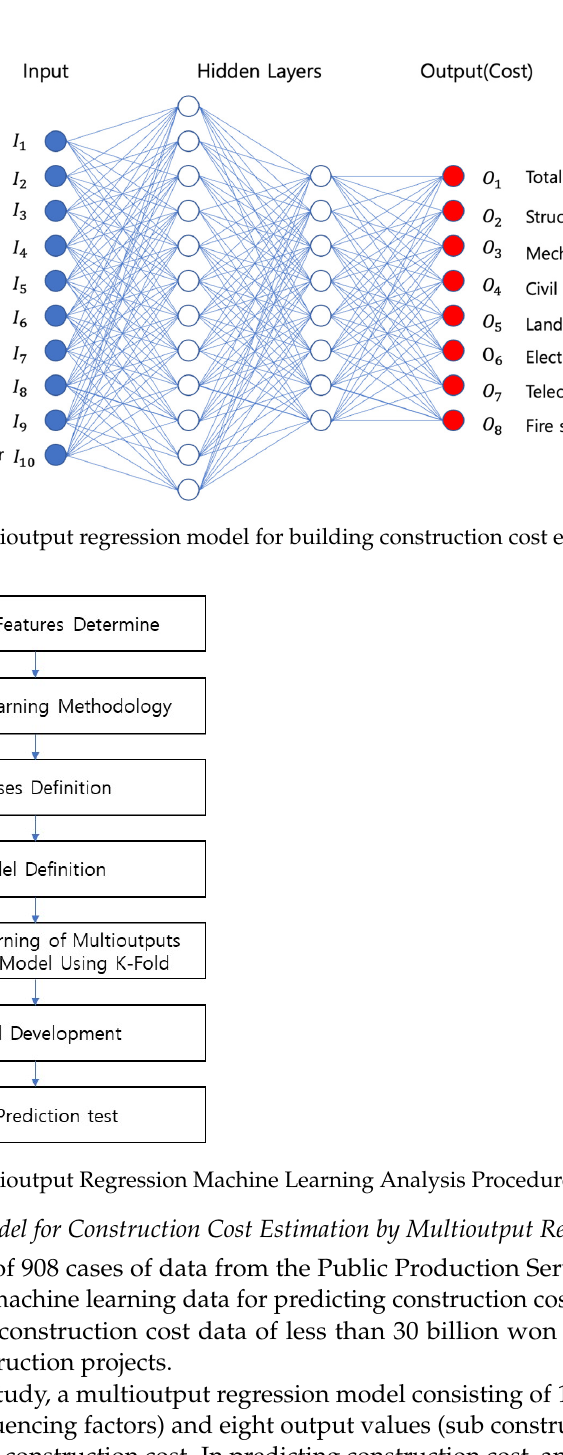
Figure 2. Multioutput Regression Machine Learning Analysis Procedure.